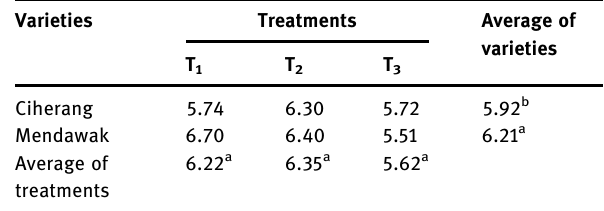
Table 2: Plant height ( cm )